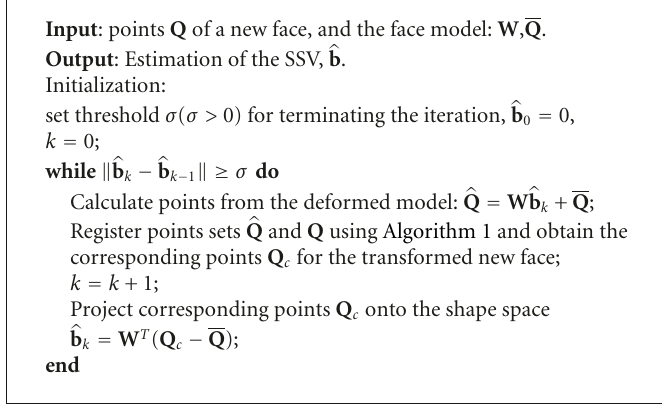
Algorithm 2: Model